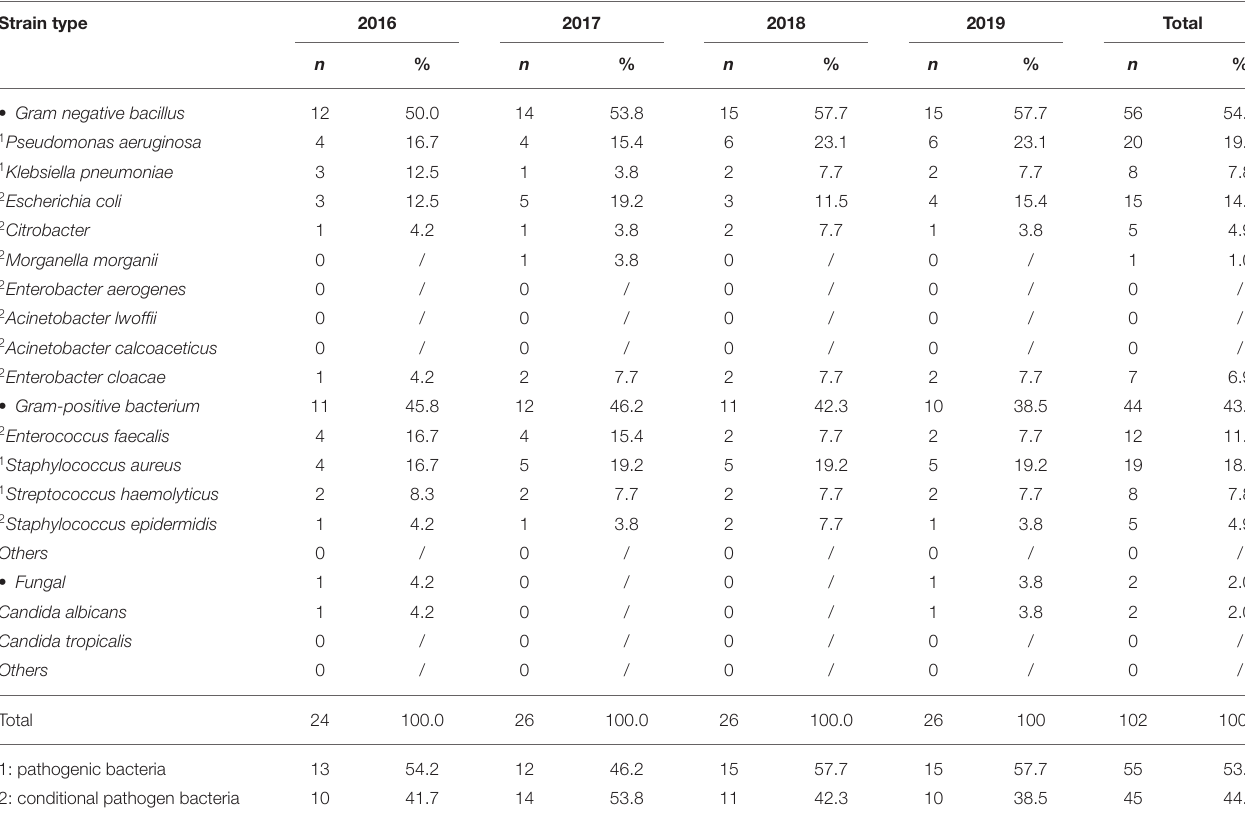
TABLE 2 | Identified pathogens from the secretions of the 102 DFI patients. Strain